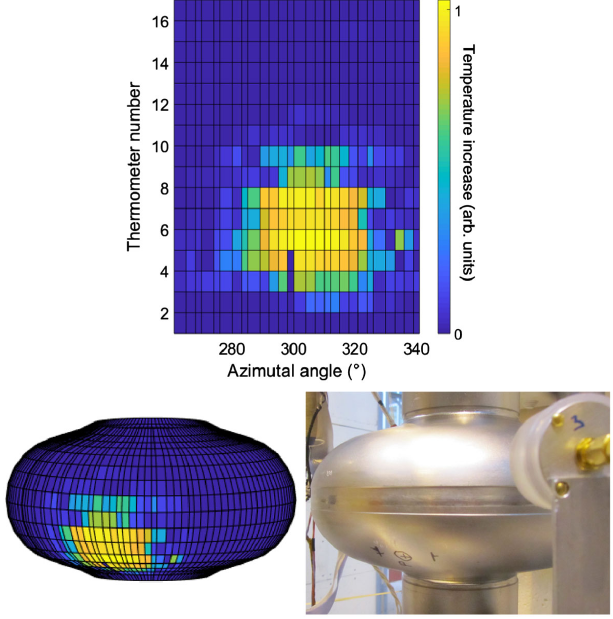
FIG. 3. Top: Thermal cartography of Cavity B during a test. Azimuthal angle gives the temperature mapping position around the cavity; thermometer number can be read in Fig. 1. Bottom: Cartography projection on cavity surface (left) and identification of the quench spot on the cavity marked by ⊕ symbol